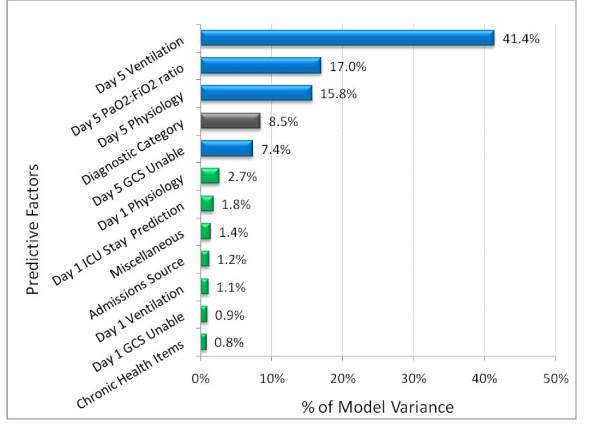
Percentage of model variance attributable to factors used to predict intensive care unit length of stay remaining after day 5. Physiology refers to the acute physiology score (APS) and rescaled Glasgow Coma Score. Rescaled PaO2/FiO2 ratio is defined in Appendix Table 1. GCS unable refers to inability to assess Glasgow Coma score due to sedation or paralysis. Diagnostic category includes 57 mutually exclusive diagnostic groups on day 5. Miscellaneous includes age, prior length of stay, emergency surgery, and ICU readmission.